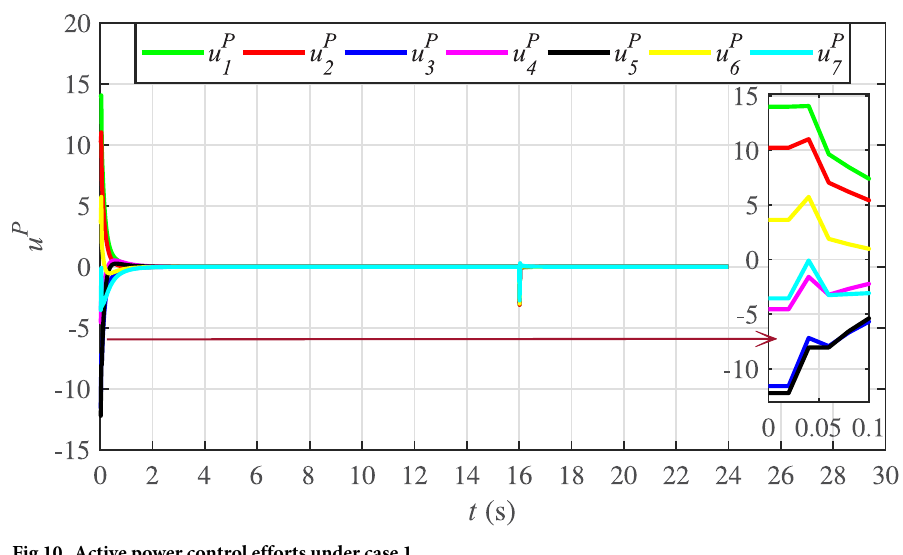
Fig 10. Active power control efforts under case 1.